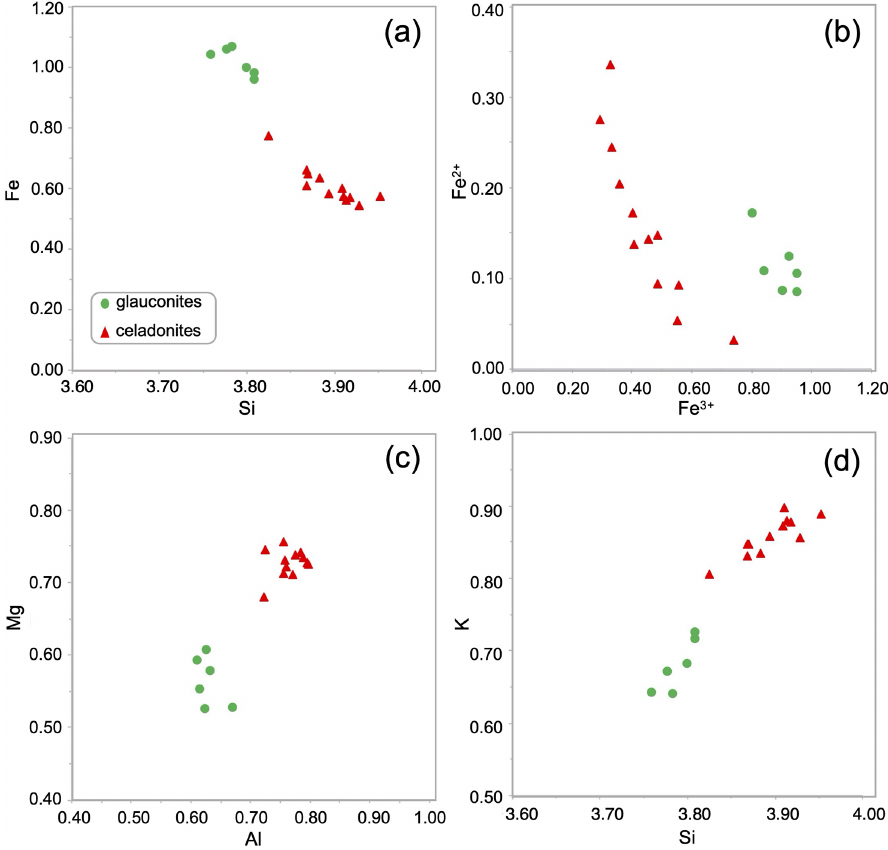
Figure 4. Chemical plots showing the compositional ranges of the two types of green micas.